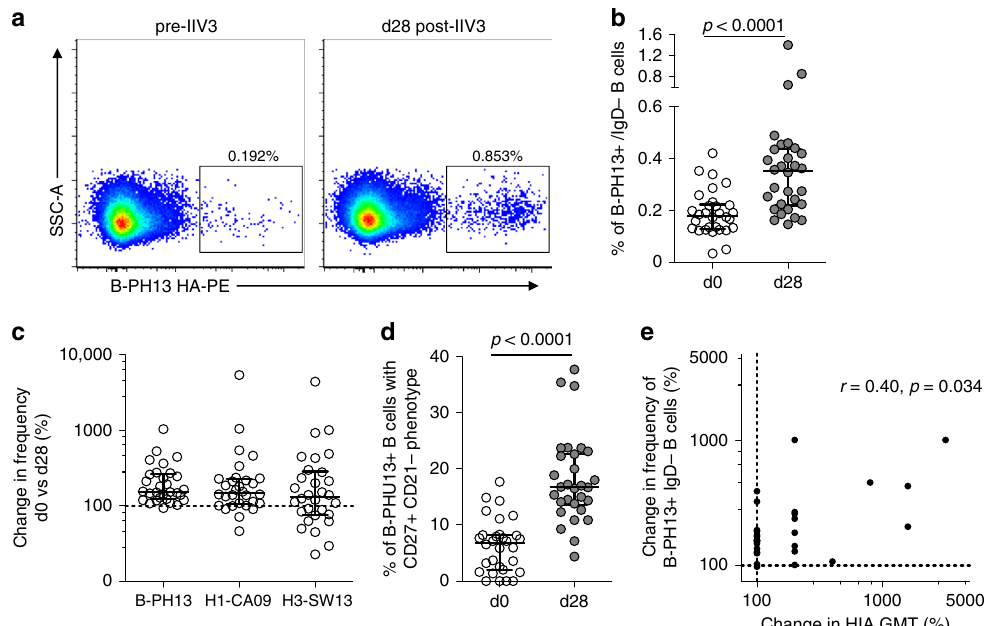
Fig. 1 Memory B cell responses to B/Phuket/3073/2013 (B-PH13) HA following IIV3 immunisation. a Cryopreserved PBMC samples were stained with a panel of monoclonal antibodies and recombinant HA probes allowing frequencies of class-switched memory B cells (CD19 + CD20 + IgD − ) B cells speci fi